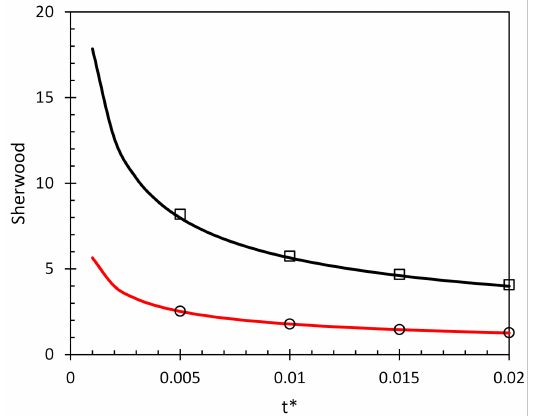
Figure A6. Sherwood number as a function of time. Black and red lines are liquid and gas mass transfer, respectively and dots are numerical